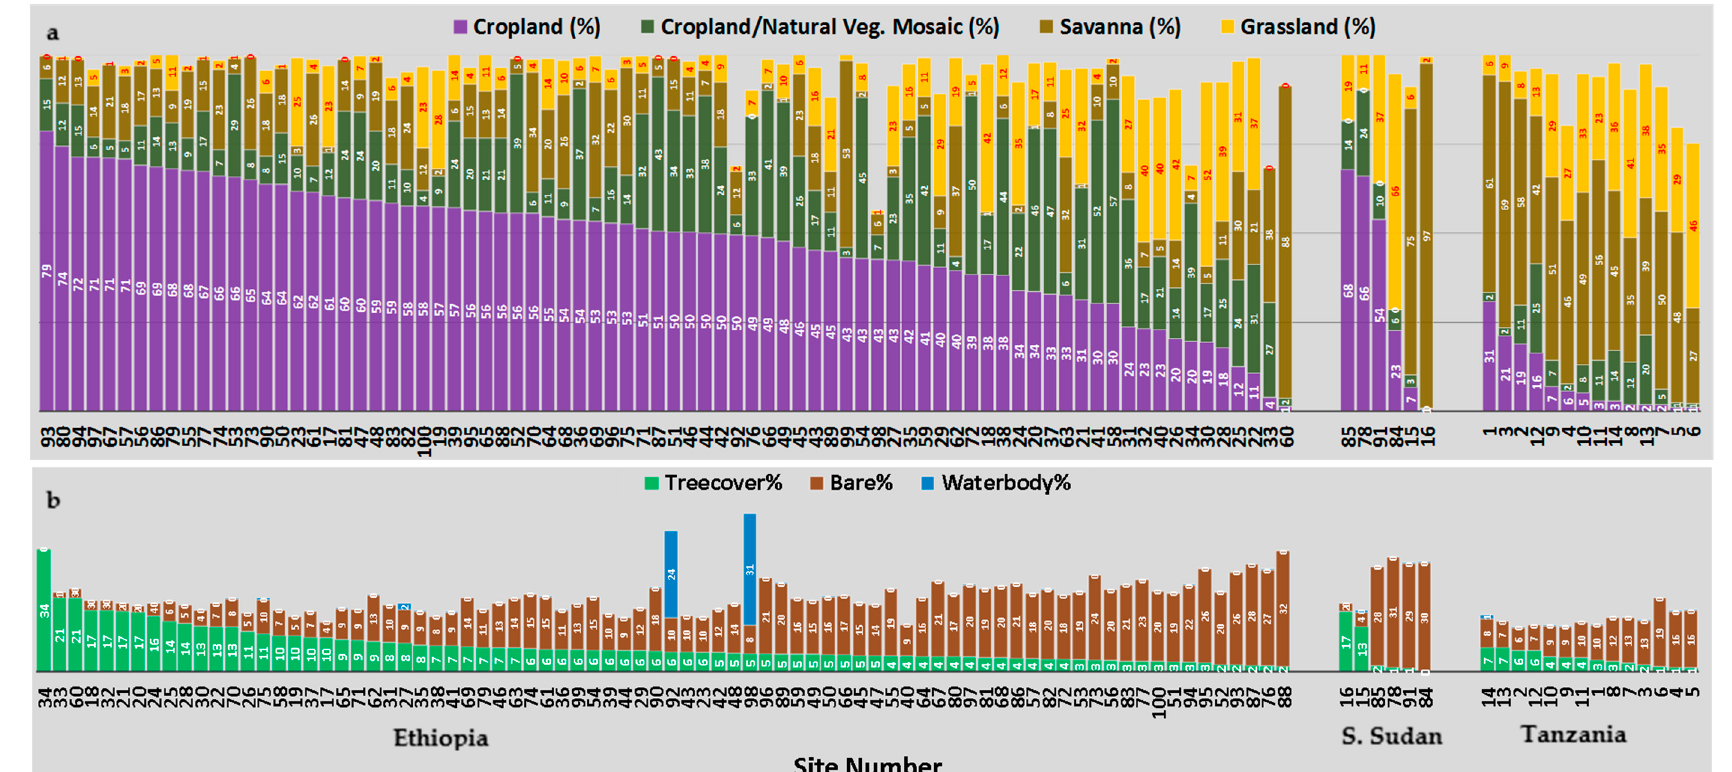
Figure 2. ( a ) Mean percentage cropland (purple), cropland/natural vegetation mosaic (green), savanna (dark gold) and grassland (gold) cover in percent for 2003–2012 from the MODIS IGBP Land Cover Type 1 Percent Product at 0.05 degree spatial resolution MCD12C1 [61]. ( b ) Percent tree cover, bare ground, and waterbody from the Landsat ETM+ 30m resolution Global Land Cover product [57]. Figure 1 shows the latitudinal distributions of the study sites and countries in which they are found numbered by latitude from south (1) to north (100). The X-axis indicates study sites, sorted by ( a ) MODIS cropland % and ( b ) Landsat treecover % from high to low. Land cover % values are labeled on the respective bars.